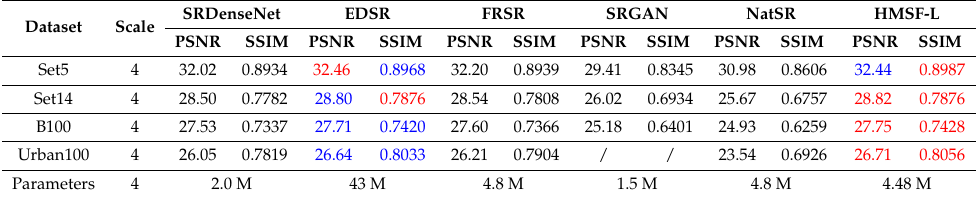
Table 13. We enlarge the HMSF to a middle size, and compare it with other state-of-the-art models that have a similar number of parameters. Red/blue text means the best/second-best performance.